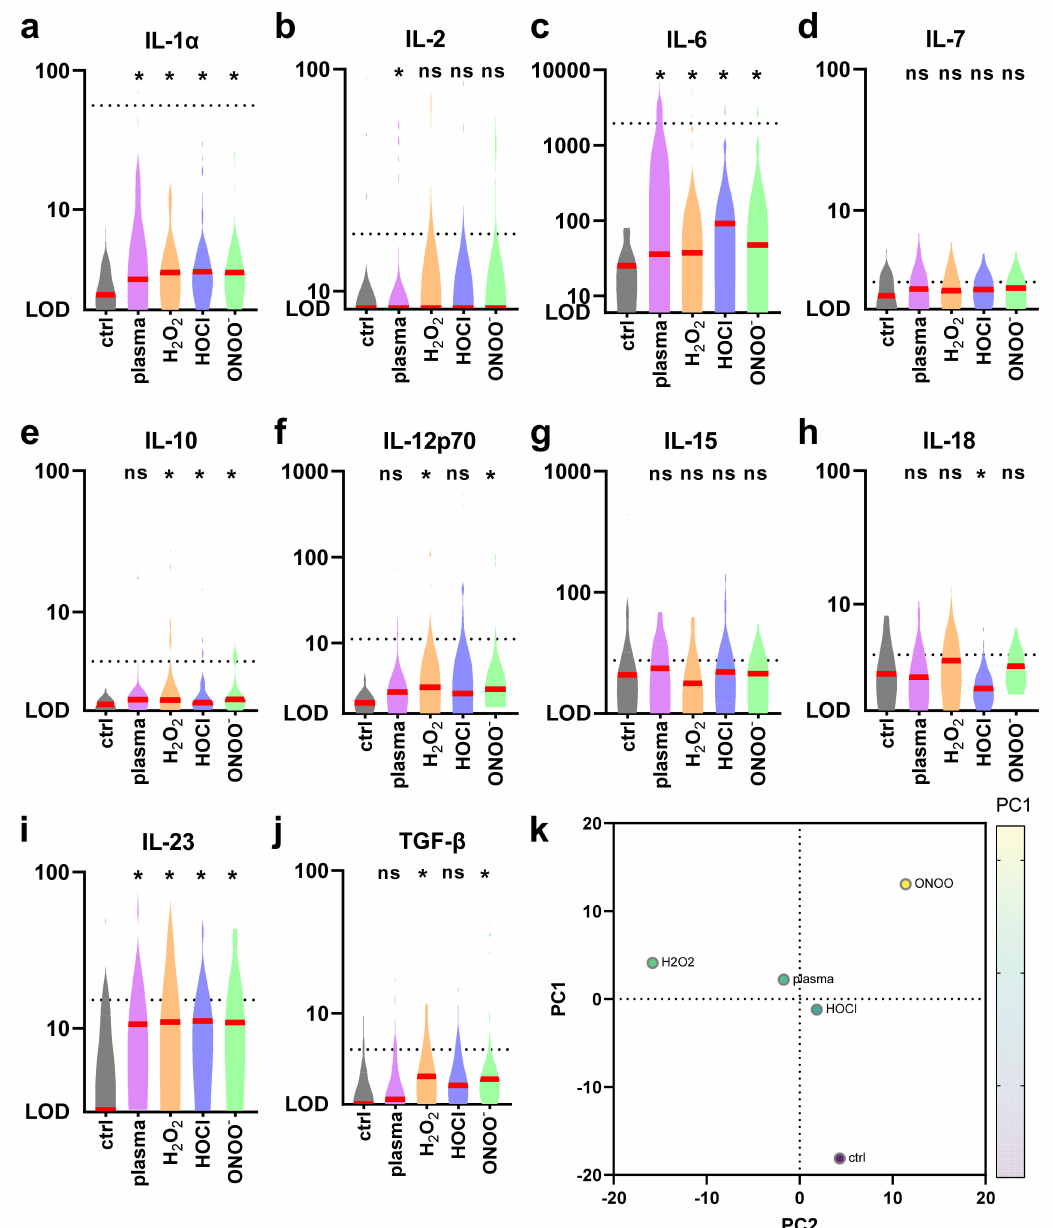
Figure 4. Argon plasma treatment and ROS/RNS modulate the cytokine release profiles. Cells were treated as indicated, supernatants were collected 24 h later, and absolute cytokine concentrations of 10 analytes ( a – j ) were assessed. All data were also related to each other using principal component analysis ( k ). Data are violin plots and median (red lines) of 3–6 different donors. Statistical analysis was done using one-way analysis of variances with p < 0.05 (*). Dashed lines show values of LPS-positive controls of moDCs included for the